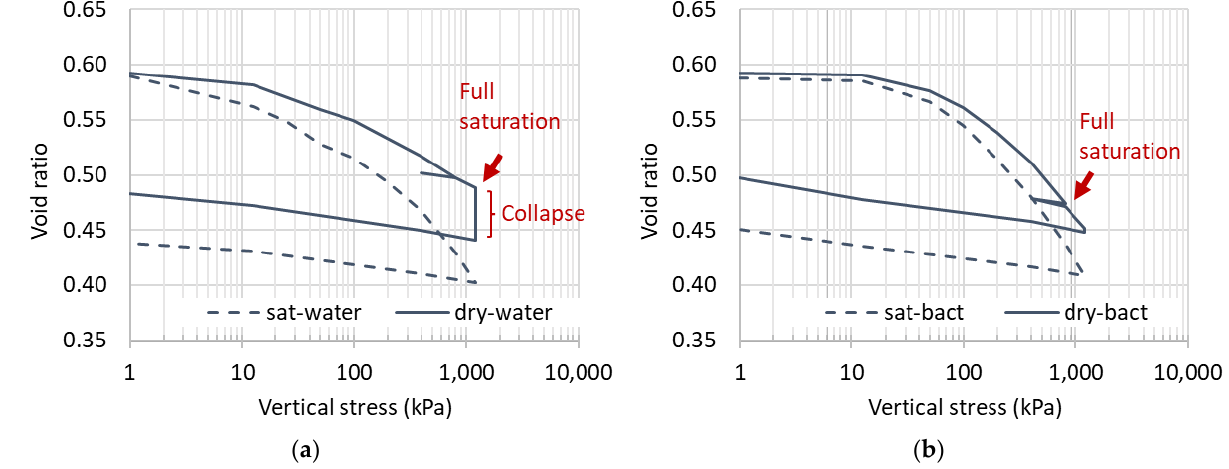
Figure 3. Oedometric curves: ( a ) untreated samples and ( b ) biocemented samples. Table 1. Results of the oedometer tests.